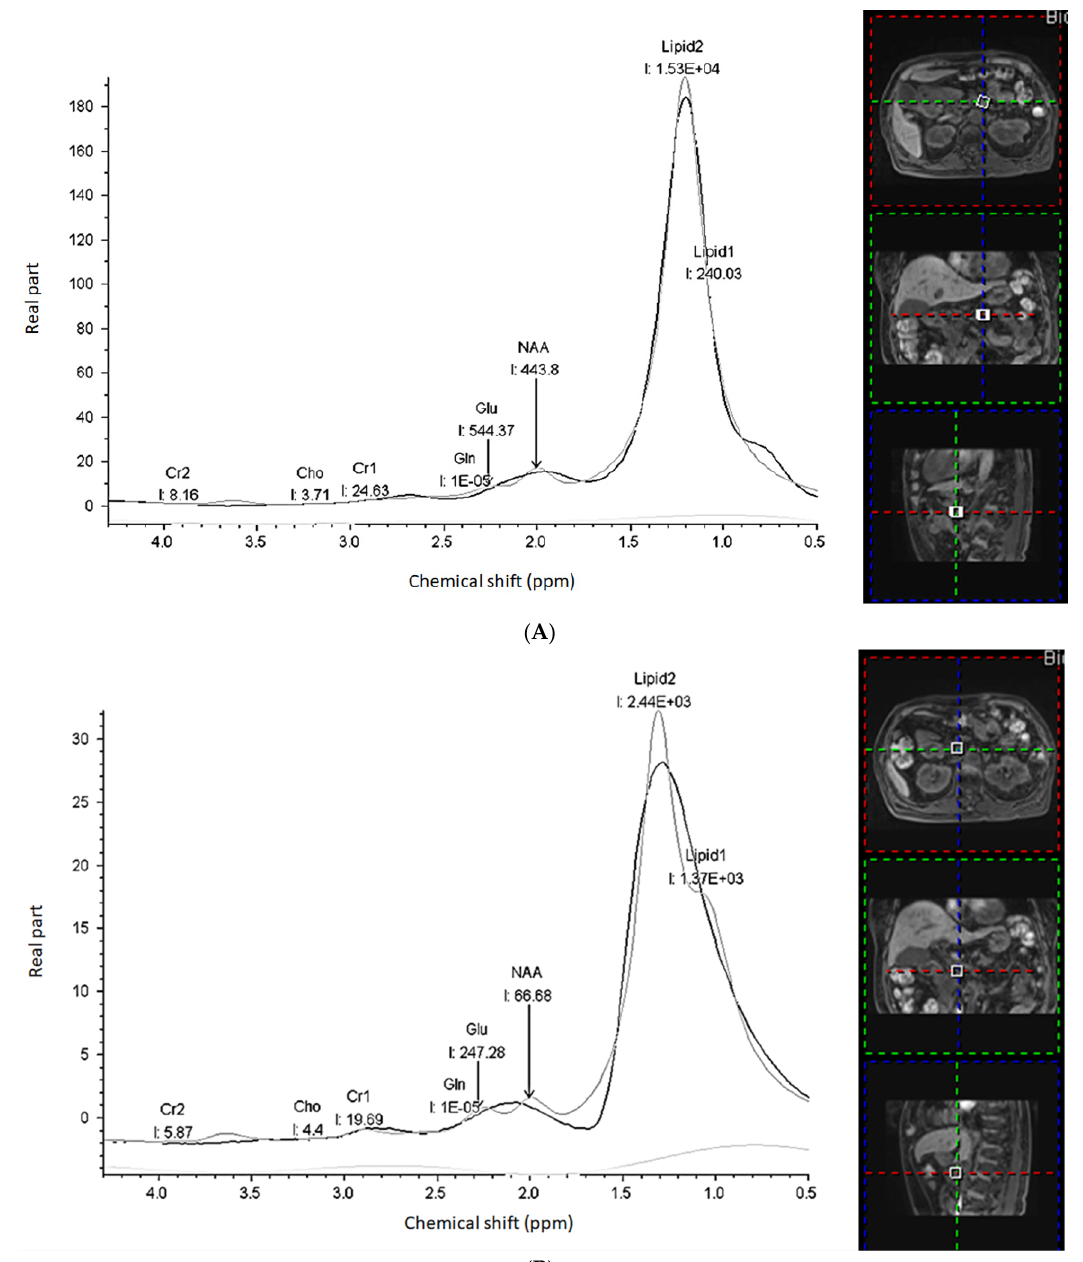
Figure 2. MRS images for a 71-year-old woman with pancreatic head cancer (T3N1M1). The progression-free survival and overall survival are 4.2 and 10.5 months, respectively. When compared to normal pancreas ( A ), the pancreatic cancer ( B ) has decreased Lipid_1, Lipid_2, NAA, Cr_1, Cr_2, and Glx.